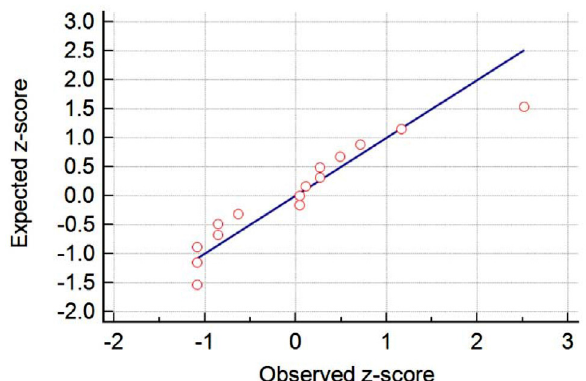
Fig. 3. Quantile-Quantile plot depicting goodness of fit